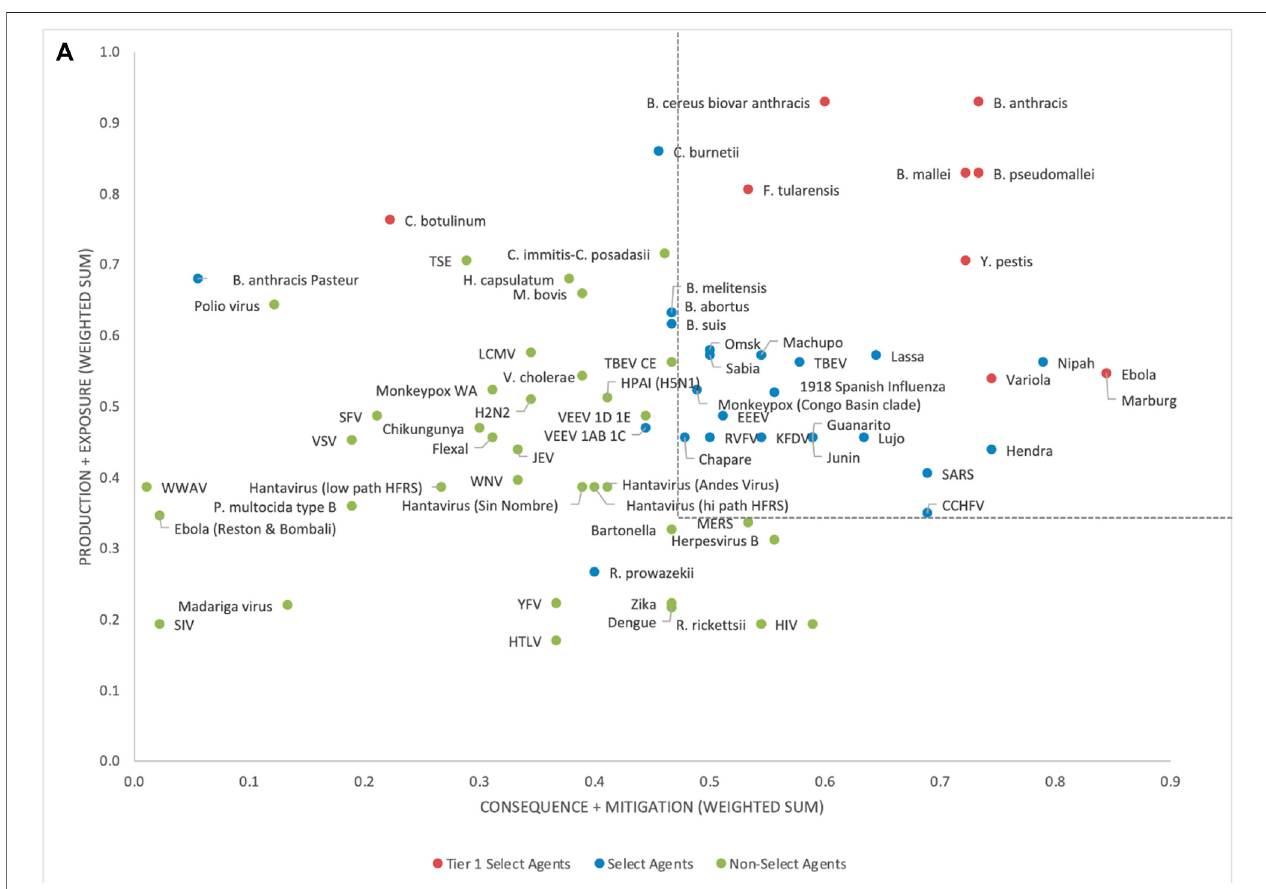
FIGURE 3 | Two-dimensional plots of unweighted (A) , 5/4/6 grouping (B) and 3/3/9 grouping (C) normalized scoring